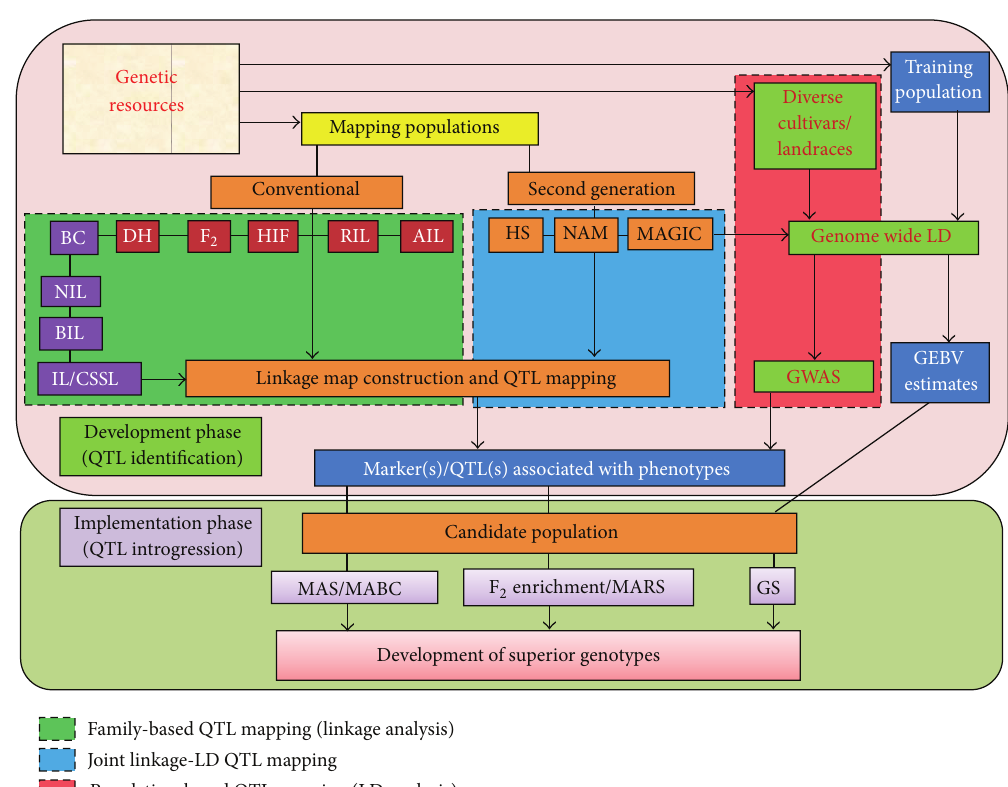
Figure 1: Schematic representation of genomics assisted crop improvement. ∗ DH: Double haploid; BC: Backcross population; RIL: Recombinant inbred line; AIL: Advanced intercross line; HIF: Heterogeneous inbred family; NIL: Near isogenic line; BIL: Backcross inbred line; IL: Introgression line; CSSL: Chromosome segment substitution line; HS: Heterogeneous stocks; NAM: Nested association mapping; MAGIC: Multiparent advanced generation intercross; MAS: Marker assisted selection; MABC: Marker assisted backcrossing; MARS: Marker assisted recurrent selection; GWAS: Genome-wide association study; GS: Genomic